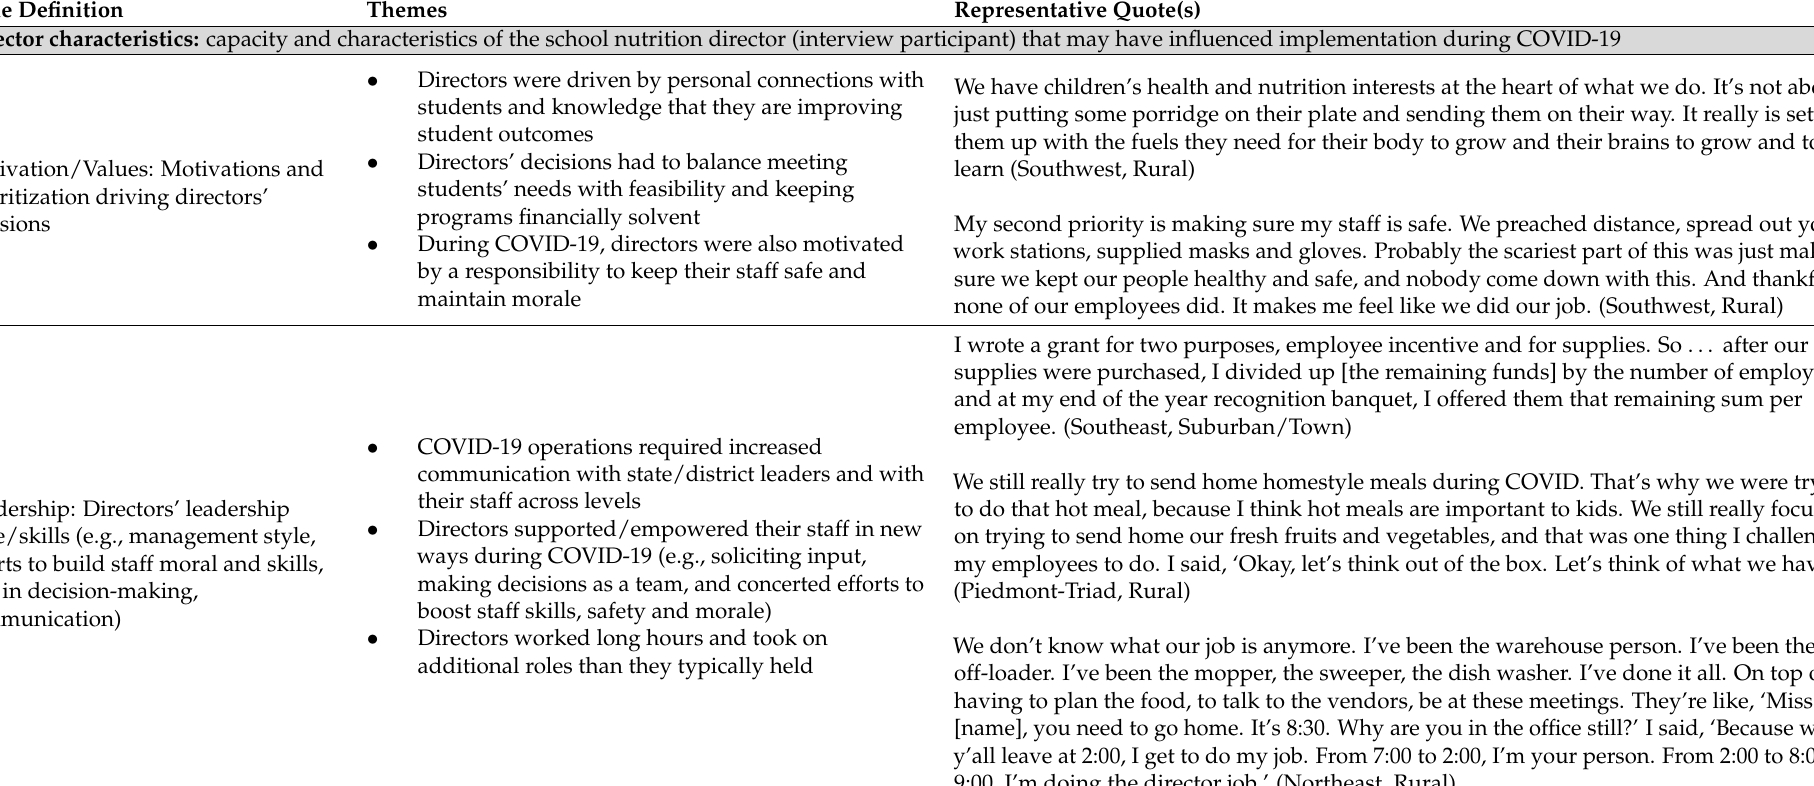
Table 2. Themes and representative quotes related to implementation factors influencing school meal program operations during the early months of COVID-19, including future anticipated